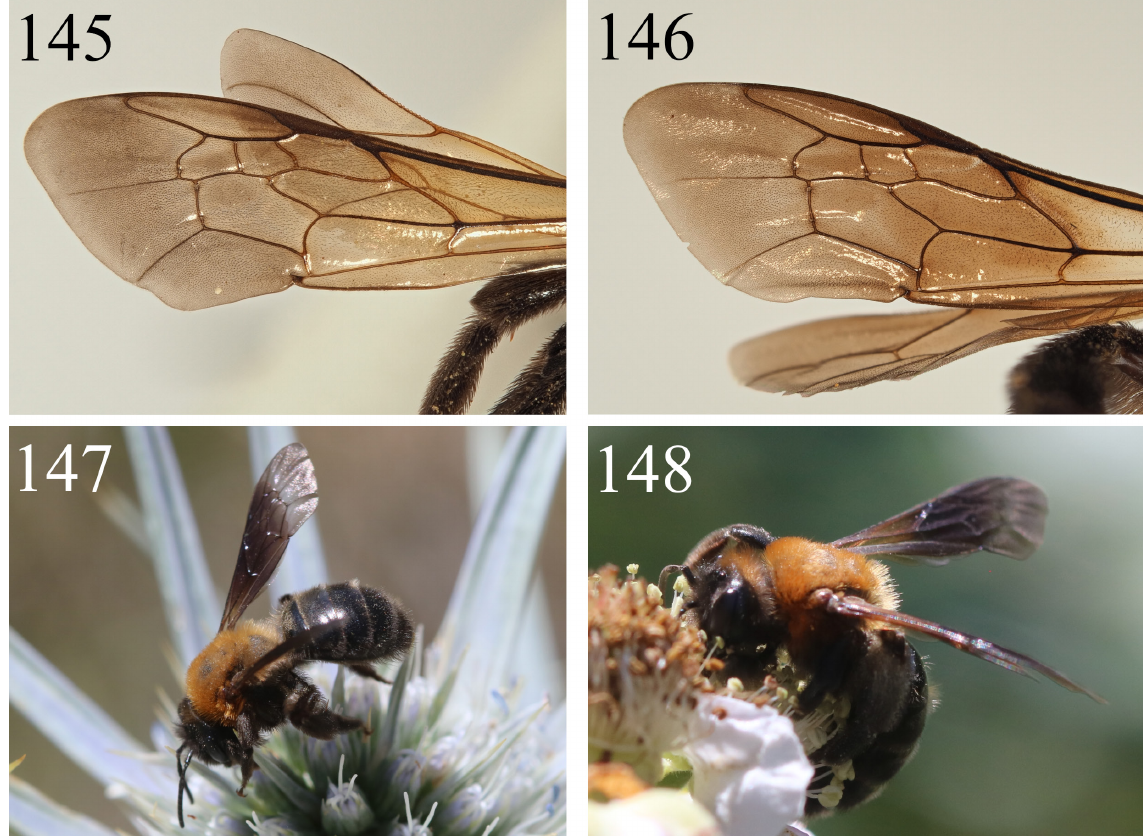
Figs 145–148. Andrena assimilis Radoszkowski, 1876 from Spain. 145 . ♀ (OSCA), wing, detail (Setcases, Girona). 146 . ♀ (OSCA), wing, detail (Puerto de Somosierra, Madrid). 147 . ♀, on Eryngium sp. (Trevélez, Sierra Nevada, Granada). 148 . ♀, on Rubus sp. (Navacepeda de Tormes,